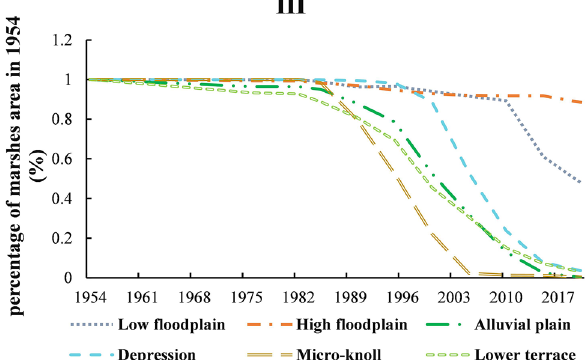
Figure 8. The distribution of marsh during 1954–2020 based on geomorphic types in Bielahong River_Wusuli river. As Figure shown that the main geomorphic types of Bielahong River_Wusuli river region were alluvial plain, depressions, lower terrace, low floodplains, high floodplains, and micro-knoll. Farmland reclamation first occurred in alluvial plain, lower terrace, and high floodplain, then to micro-knoll, low floodplain, and alluvial